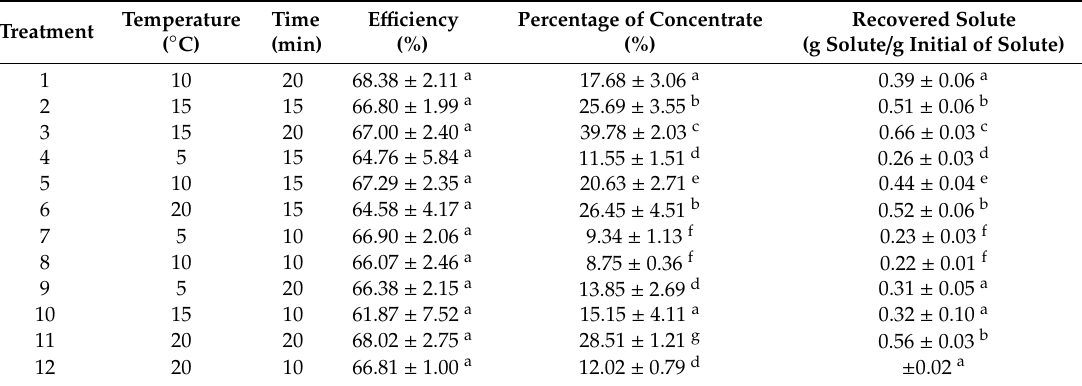
Table 2. Results of e ffi ciency, percentage concentrate and recovered solute.